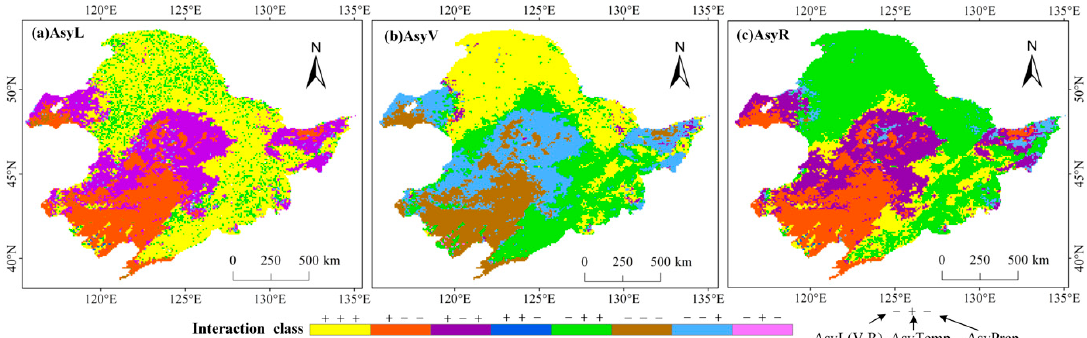
Figure 12. Spatial patterns of the influence of temperature and precipitation on vegetation asymmetries. This is an inter-comparison between average annual asymmetries of AsyL (AsyV, AsyR), AsyTemp and AsyPrcp. An interaction noted as ‘ − + − ’ successively represents negative AsyL (V, R), positive AsyTemp and negative AsyPrcp from the average annual mean.